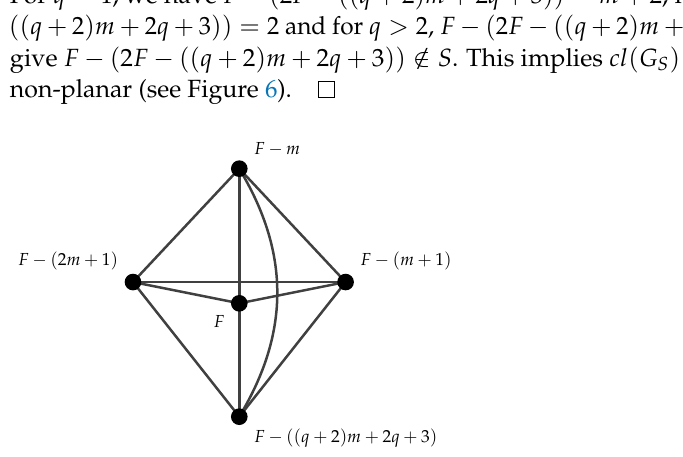
Figure 6. Minimum possible clique for the case m ≥ 2 q + 3, e = m − 2 q and q ≥